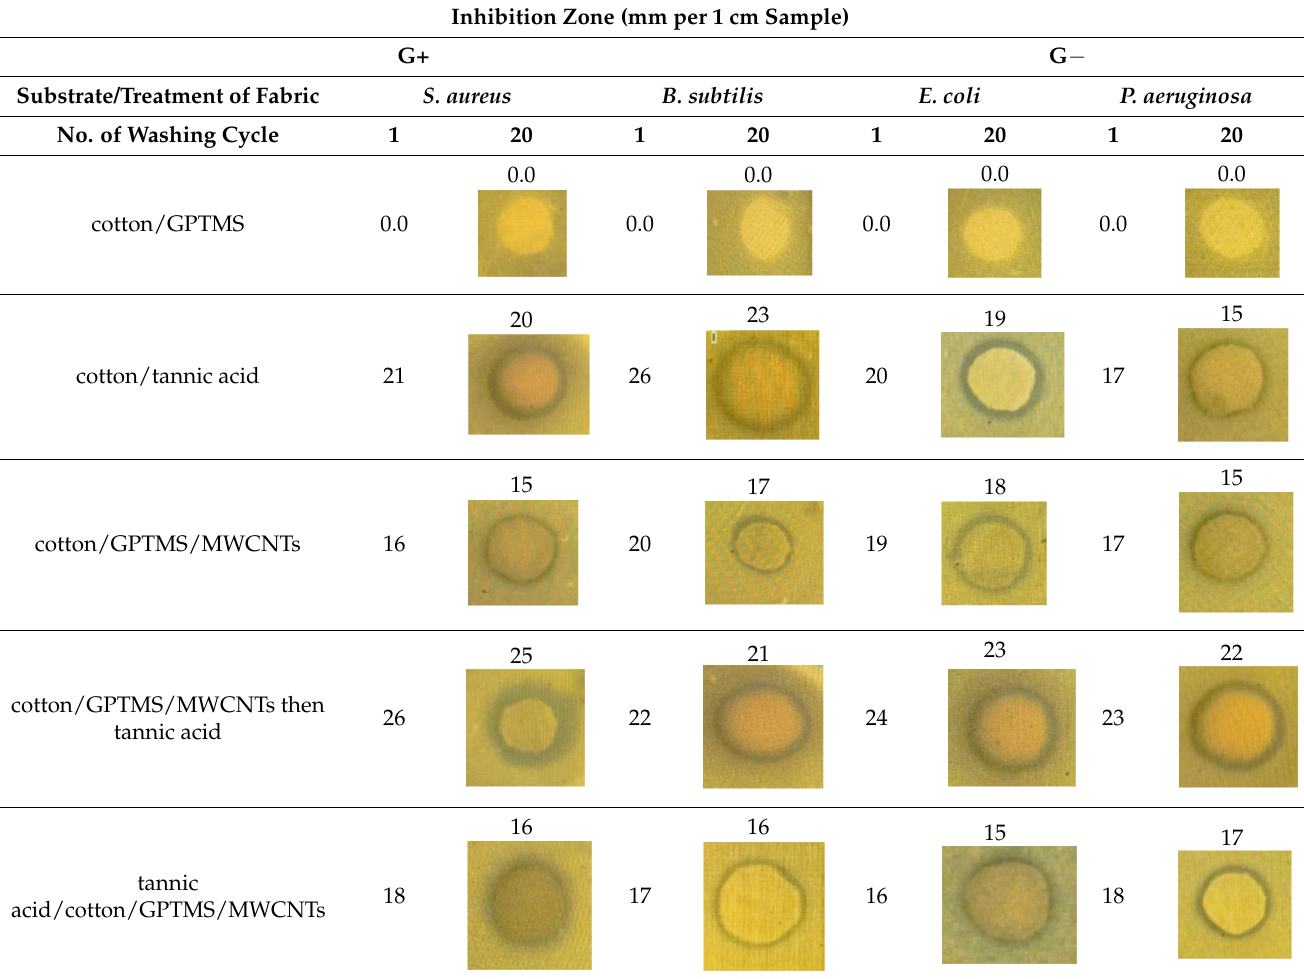
Table 1. Antibacterial activity and durability properties.